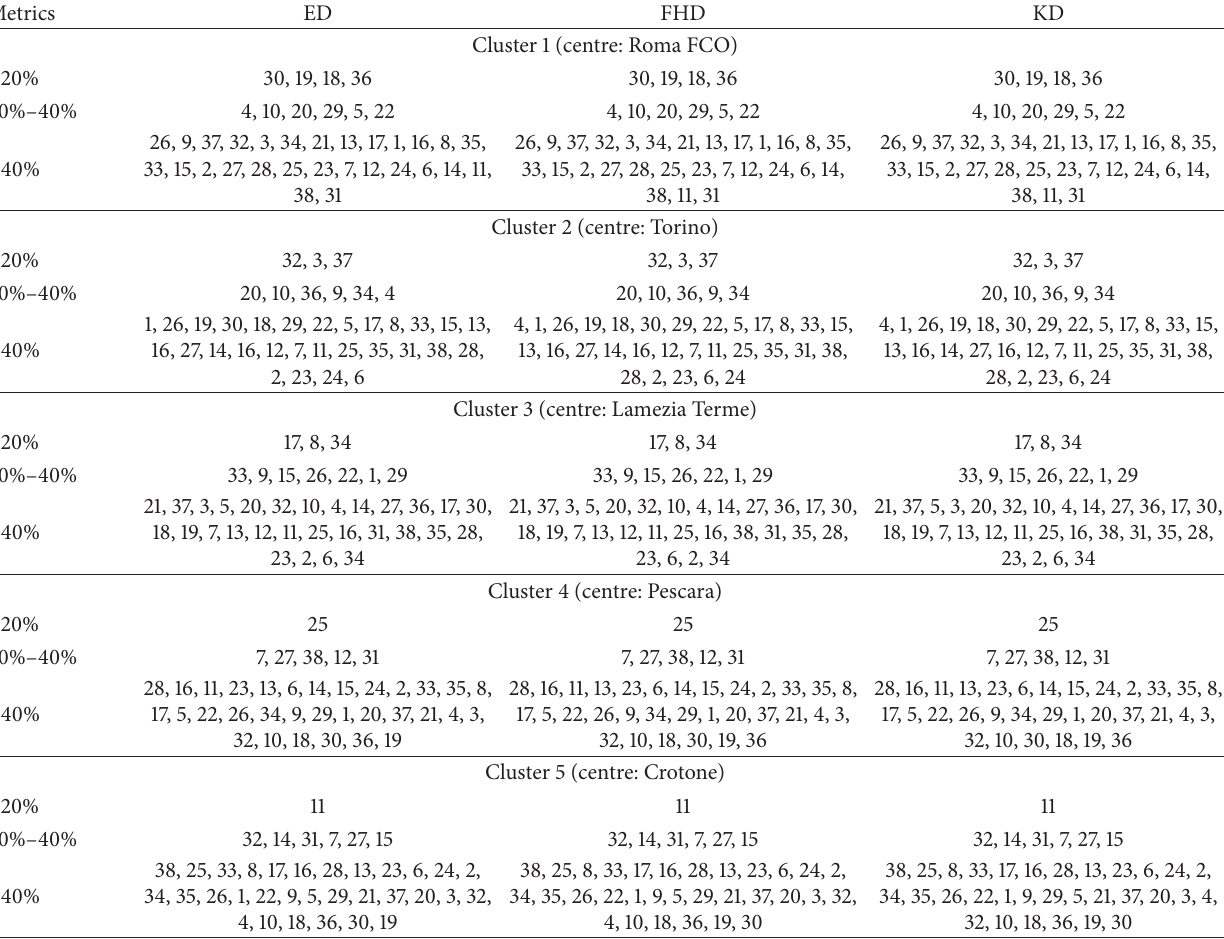
Table 6: Clustering results without prefixing the number of clusters. Criterion: yearly movements.